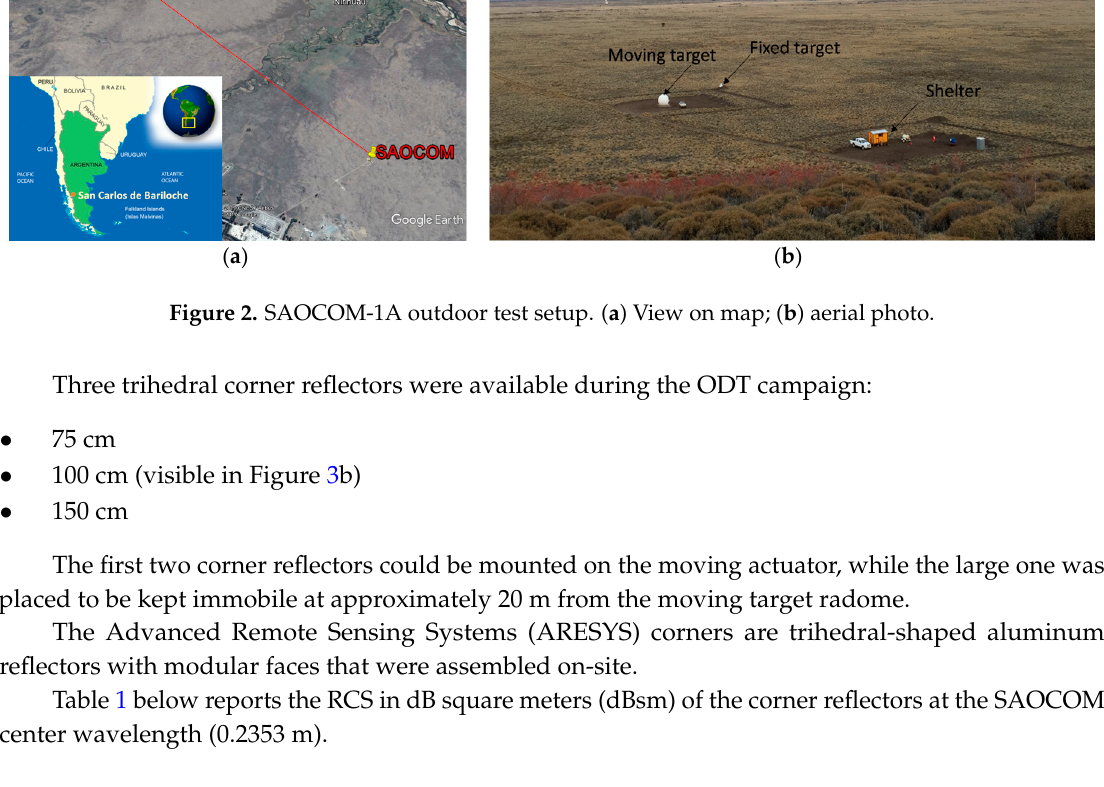
Table 1. Radar Cross Section (RCS) of the corner